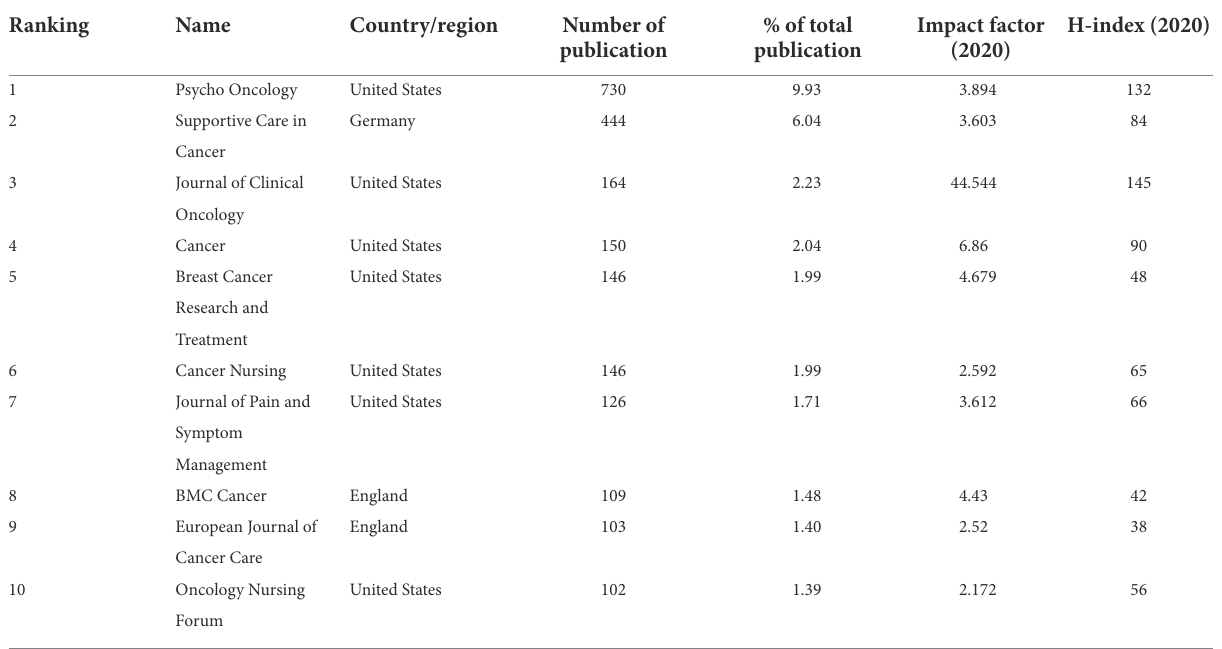
TABLE 3 The top 10 journals related to depression in breast cancer.